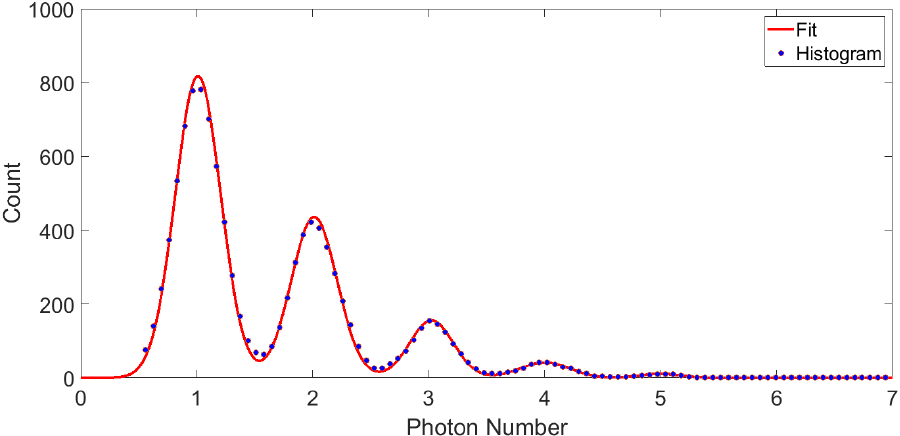
Figure 10. Amplitude histogram of the photon response curves and its fit by the Poissonian emission distribution function (0-photon peak not